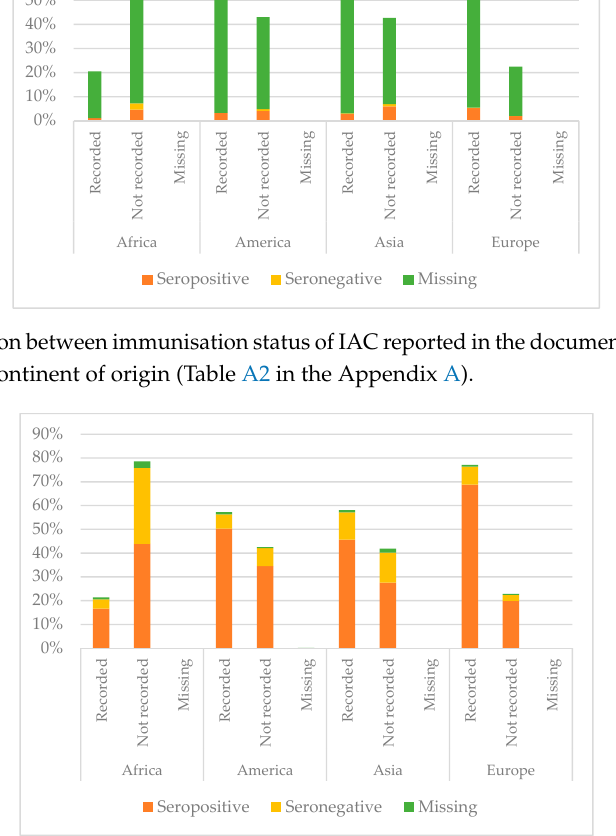
Figure 6. Comparison between immunisation status of IAC reported in the documentation and serology for tetanus, by continent of origin (Table A3 in the Appendix A). Vaccines 2020 , 8 , x